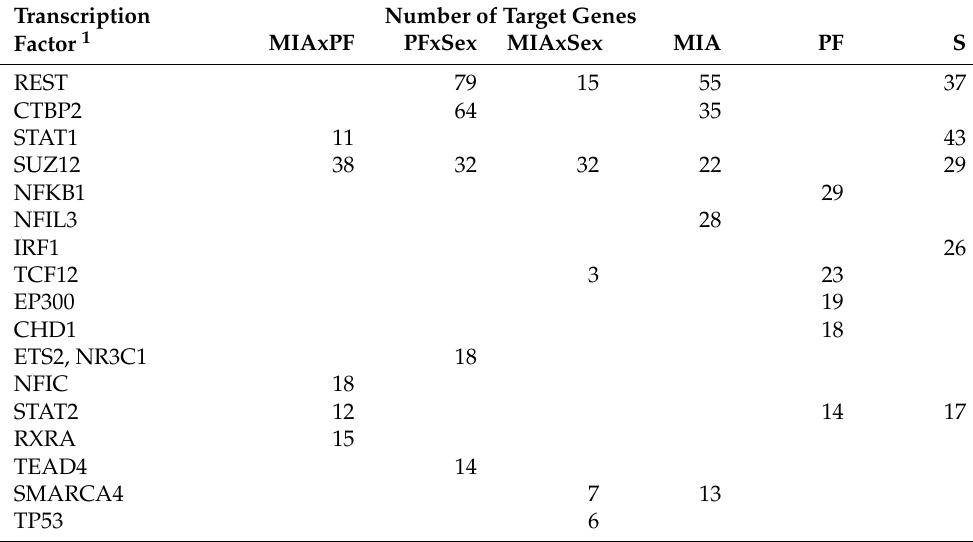
1 transcription factors are sorted from highest to lowest number of target genes for the effect with the highest number of target